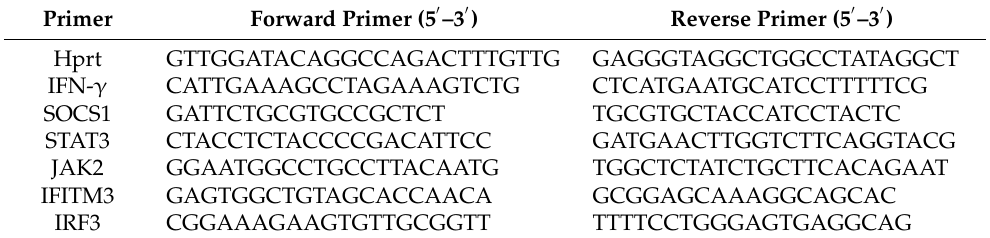
Table 1. Primers for real-time RT-PCR were used in this study.